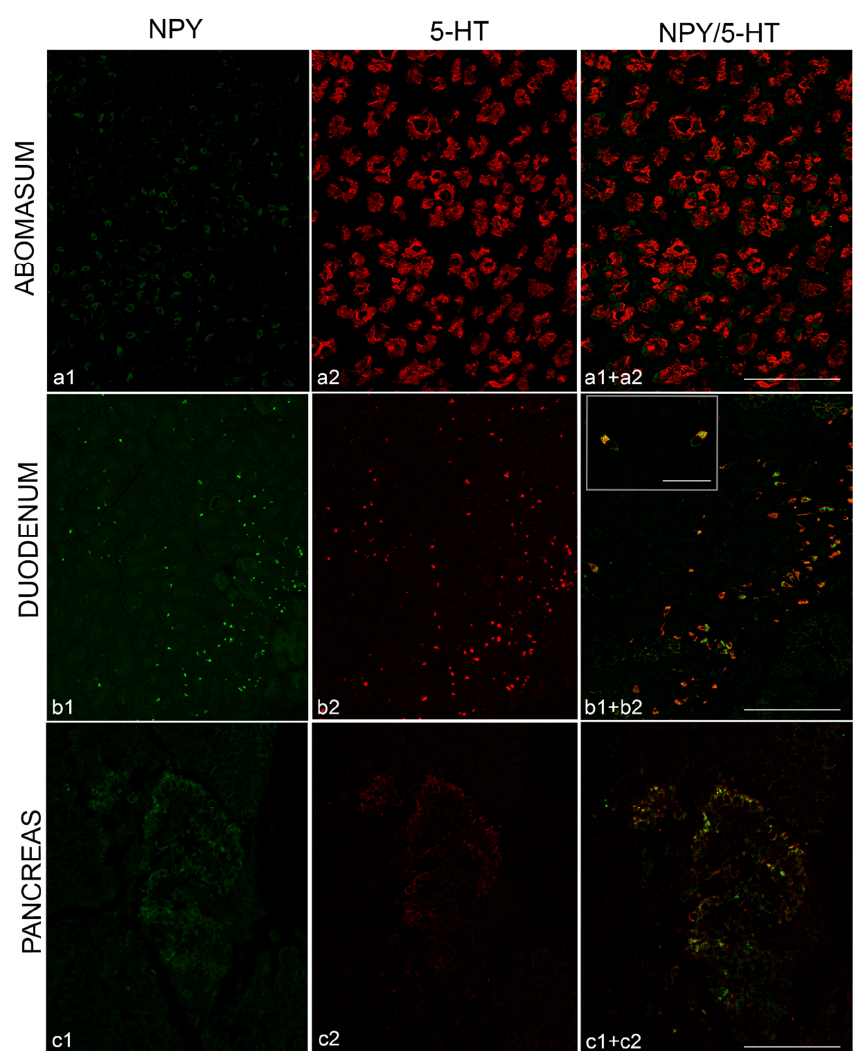
Figure 3. Immunofluorescence of NPY (green) and 5-HT (red) in the abomasum, duodenum and pancreas of goat kids fed with red orange and lemon extract (RLE) supplementation. NPY distributed in sparse cells of abomasal epithelium ( a1 ) and 5-HT in glands at the basis of gastric epithelium ( a2 ). Absence of NPY/5-HT co-localization ( a1+a2 ). NPY ( b1 ) and 5-HT ( b2 ) co-distributed in the neuroendocrine cells of duodenum, with NPY mainly localized in the cytoplasm and 5-HT on the cellular membrane ( b1+b2 ). NPY ( c1 ) and 5-HT ( c2 ) in the pancreatic islet, localized in different cells ( c1+c2 ). Scale bar: (a) = 25 μm; (b,c) = 50 μm.